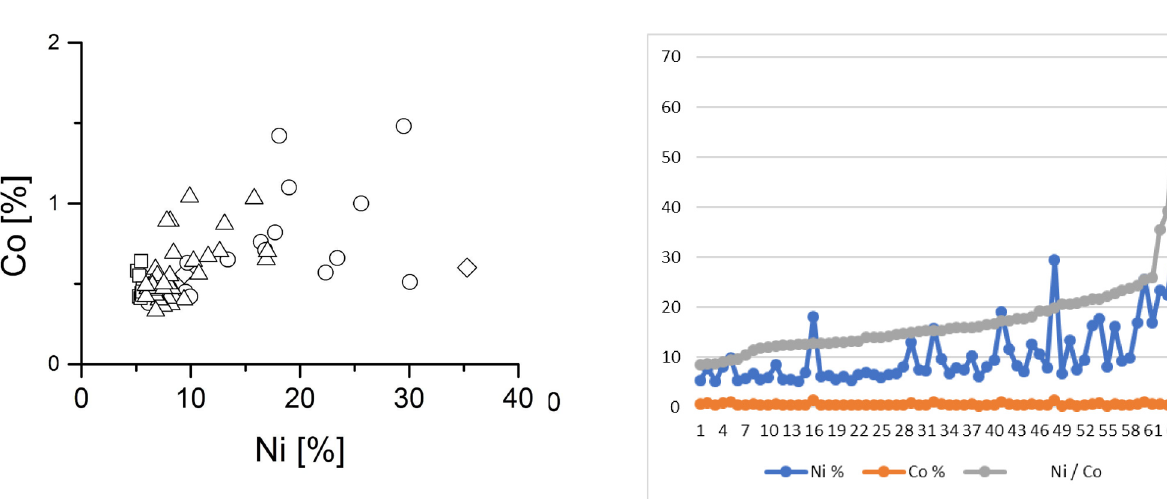
Figure 6. Nickel/cobalt ratios in iron meteorites. Data from Table